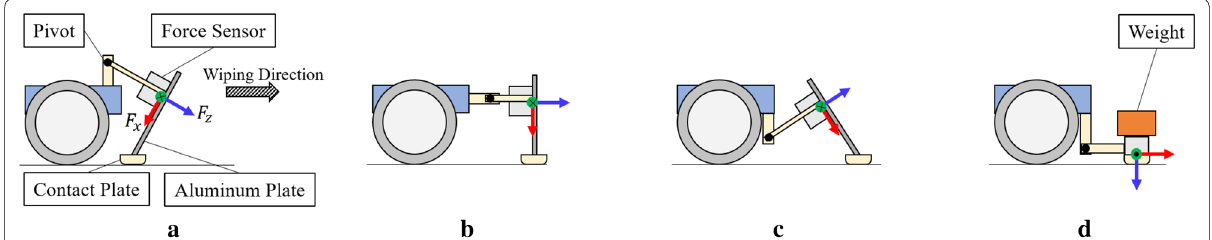
Fig. 6 Five kinds of wiping device. a Type A, b Type B, c Type C, d Type